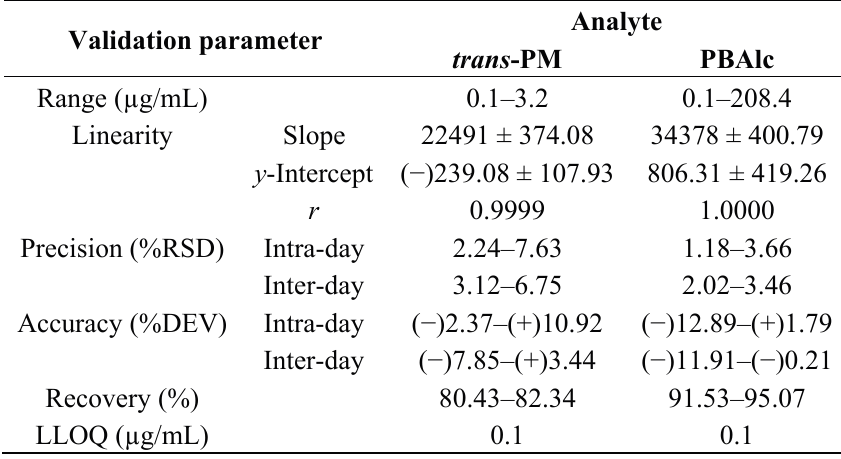
Table 1. Method validation for analysis of trans -permethrin (PM) and phenoxybenzylalcohol (PBAlc) in rat